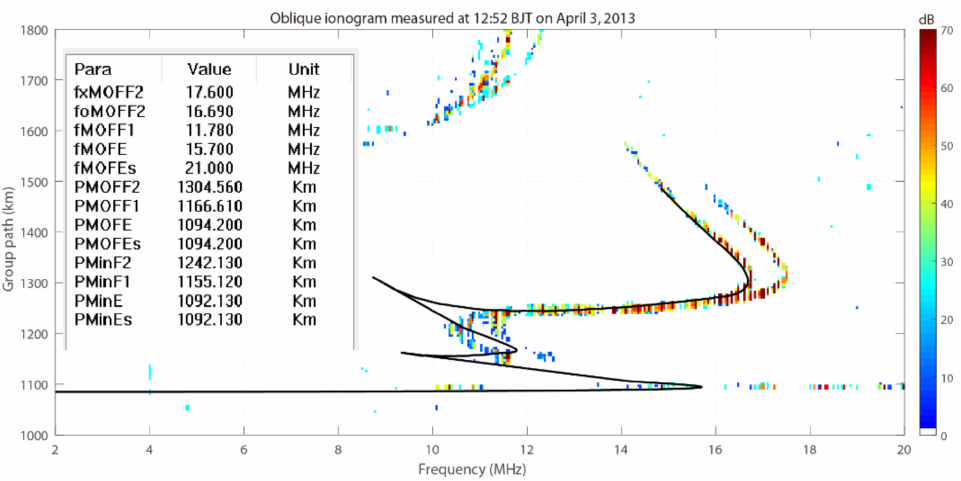
Figure 6. Oblique ionogram measured at 12:52 BJT on 3 April 2013 with the best-fit synthesized trace (a black line) and best-fit parameters.